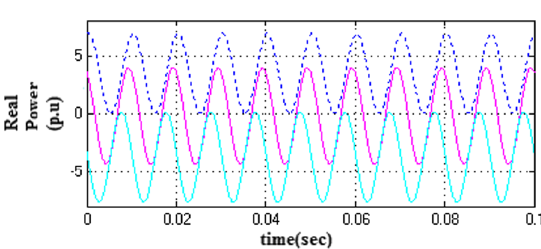
Fig. 21 Real power flow at bus 7 with ANFIS switching of STATCOM of IEEE 9 -bus system